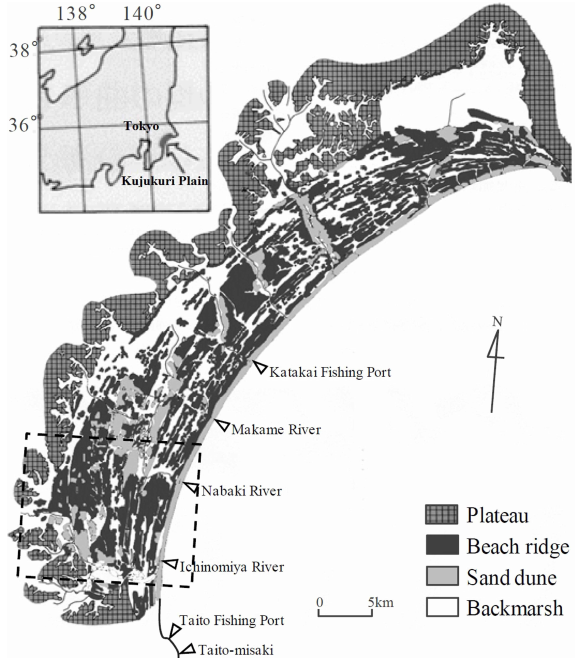
Figure 1. Geomorphological map of the Kujukuri Plain (Obanawa et al., 2010). Square marked by dashed line indicates the study area.